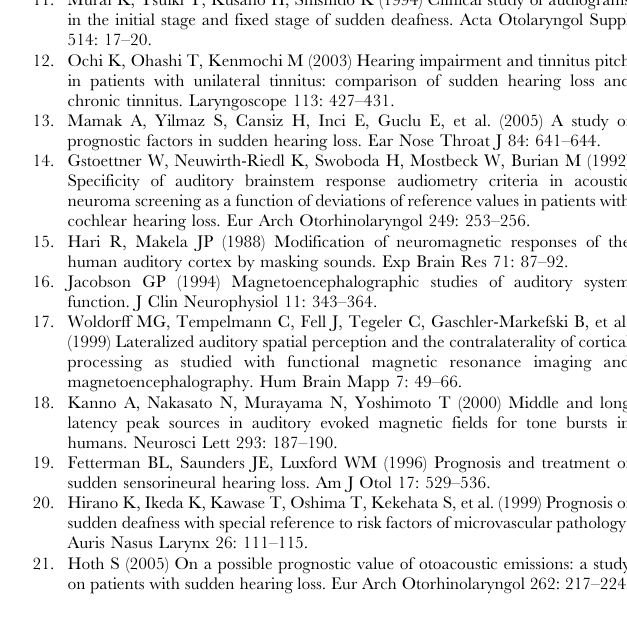
Table S2 Relative position of N100m peak dipole at